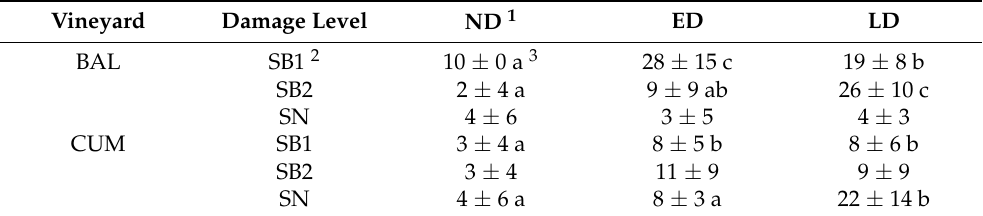
Table 2. Percentage (%) of berries exhibiting sunburn damage in BAL and CUM bunches at harvest.